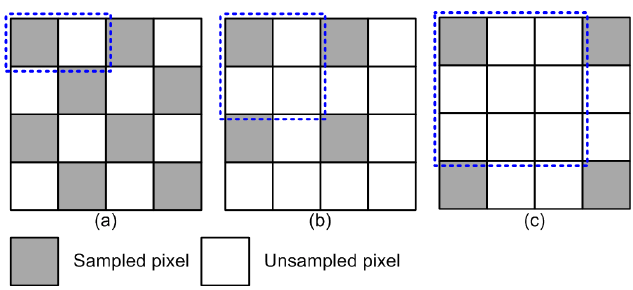
Figure 4. Examples of sampling patterns for various sampling ratios: ( a ) 2, ( b ) 4, and ( c ) 9.